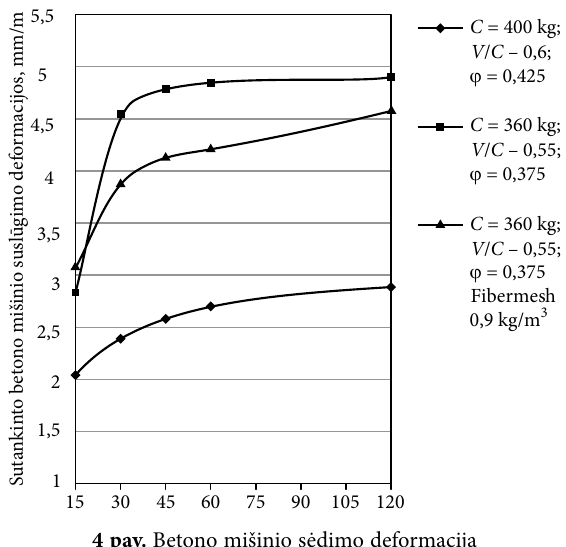
Fig. 4. Settlement deformation of compacted concrete